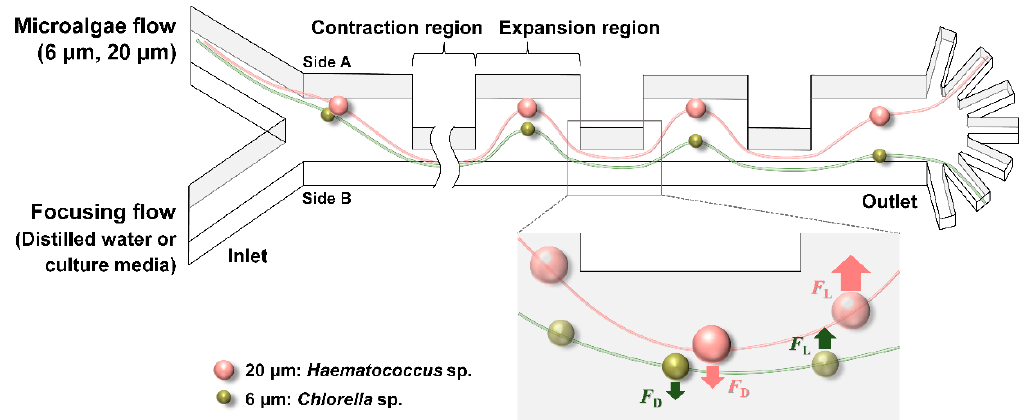
Figure 1. Schematic of a Contraction–Expansion Array (CEA) microchannel for the size-based separation of microalgae ( F D = Dean drag force, F L = inertial lift force).